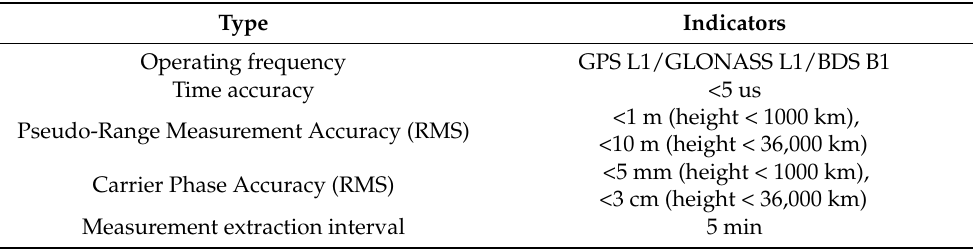
Table 1. GNSS receiver